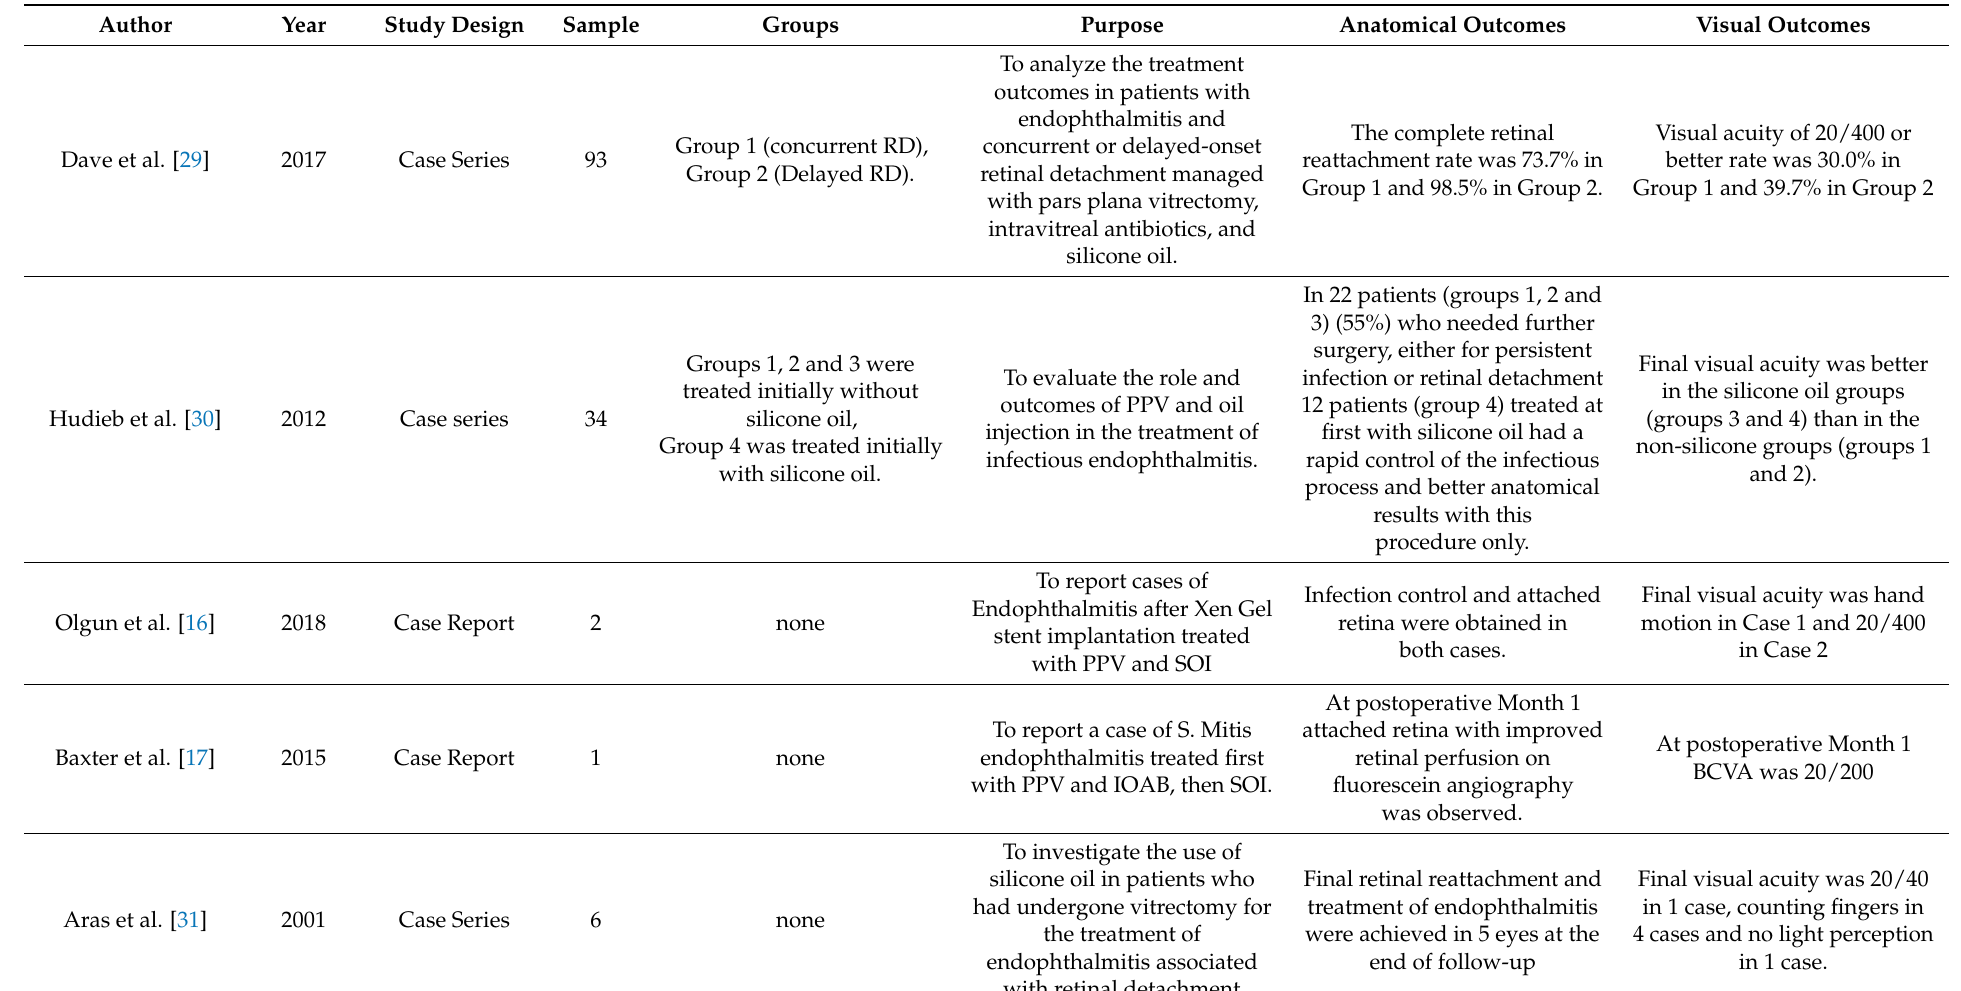
Table 2. Does Silicone oil injection after vitrectomy improve visual and anatomical